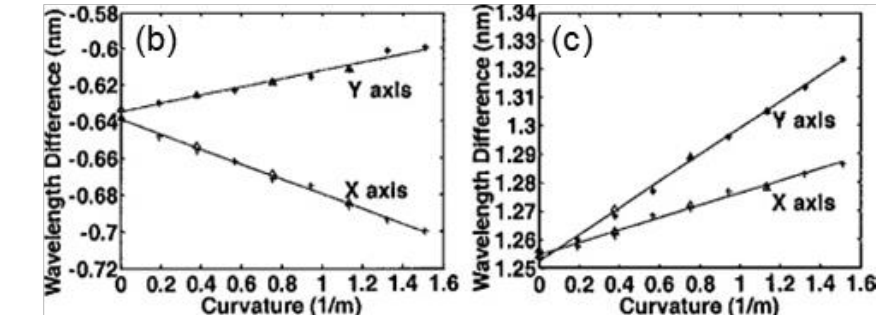
Figure 5. ( a ) The cleaved face of the four-core fiber. ( b , c ) are the measured wavelength difference versus applied curvature for x -axis and y -axis bending with a linear least-square fit: ( b ) pairing of cores 1 and 2; ( c ) pairing of cores 2 and 3. Adapted with permission from Ref. [38] © 2003 Optica Publishing Group.